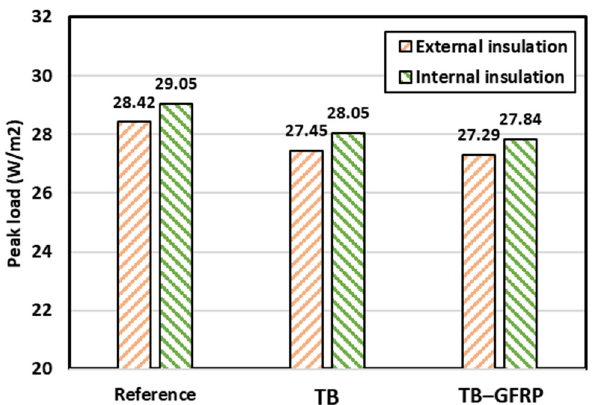
Figure 10. Peak heating load under radiant floor heating condition.